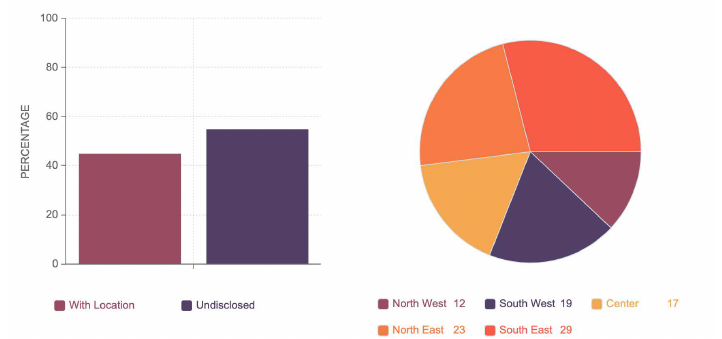
Figure 4. Zone-wise user location of tweets.